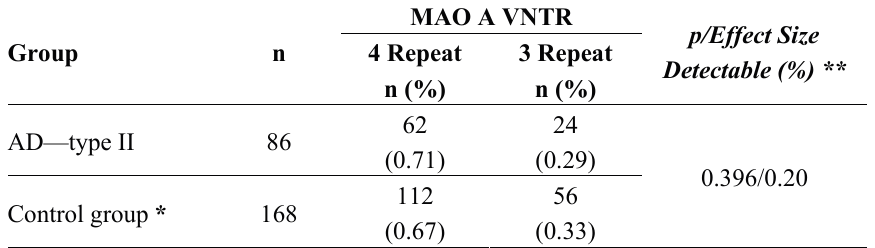
Table 3. Frequency of genotypes of the polymorphism uVNTR of the MAOA gene in patients with alcohol dependence (AD) with Lesch type II and in controls.